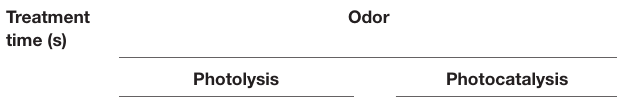
TABLE 6 | Mitigation of odor.